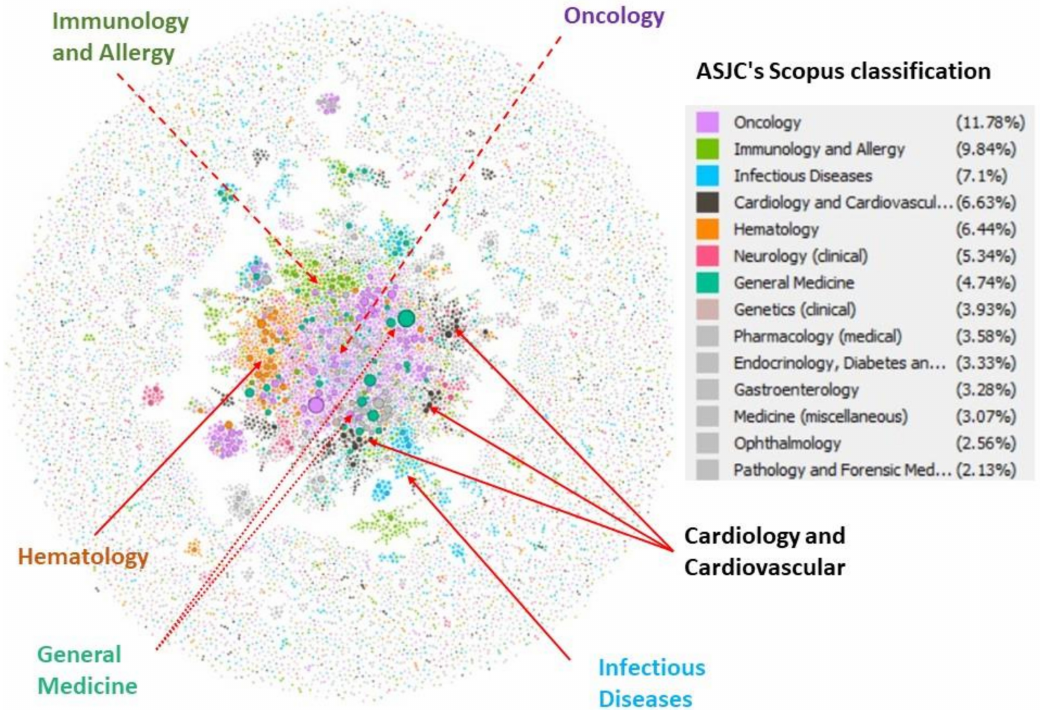
Figure 11. Relationship between publications that are cited in patents in the field of medicine according to the subcategories of medicine of the ASJC.